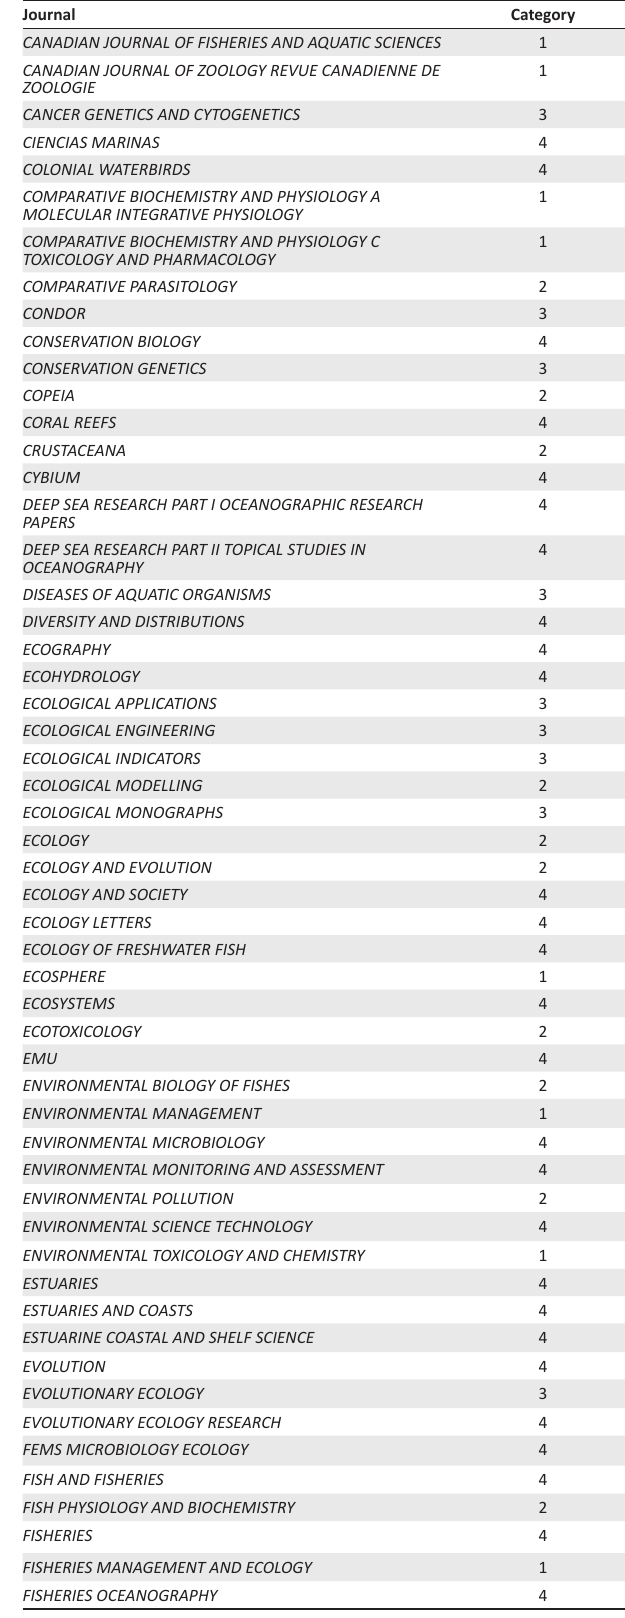
TABLE 1-A1 (Continues…): Categorisation, based on animal ethical requirements, of 250 ISI-rated, peer-reviewed, scientific journals with the most articles relating to fish research, revealed through a Web of Science (Thomson Reuters)